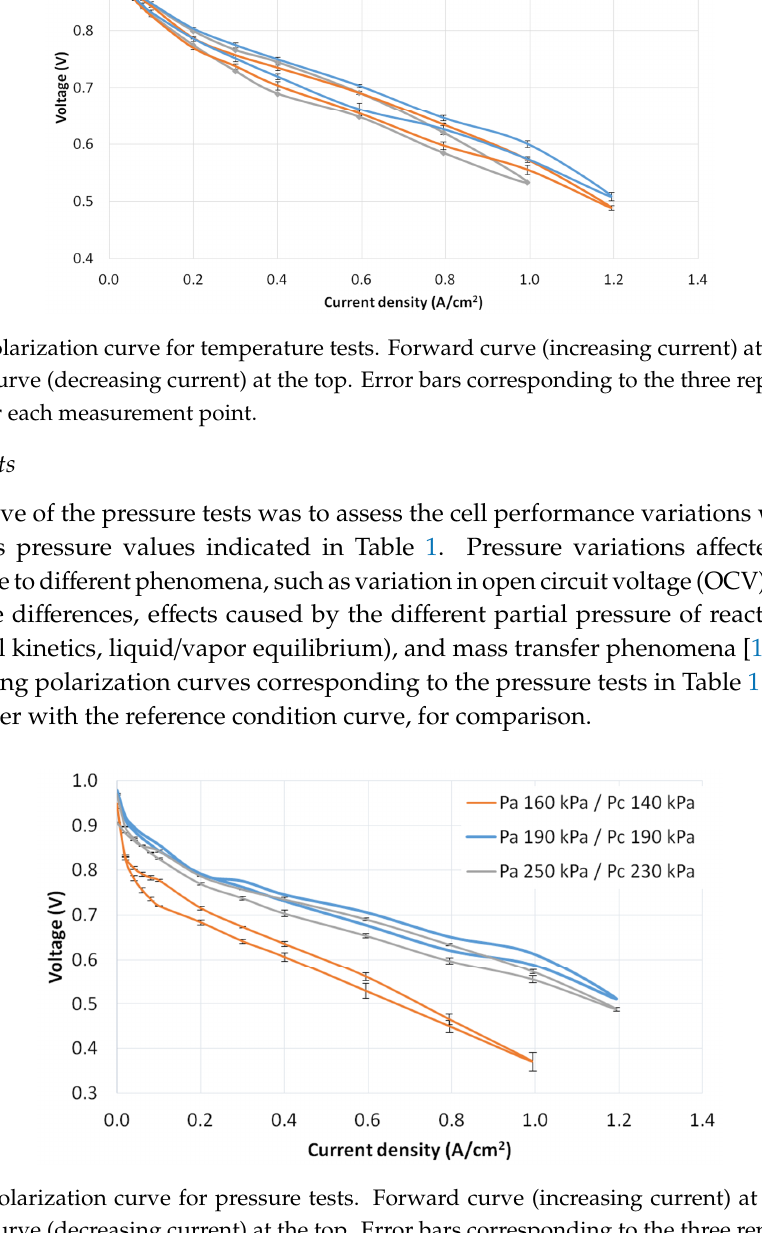
Figure 5. Polarization curve for pressure tests. Forward curve (increasing current) at the bottom; backward curve (decreasing current) at the top. Error bars corresponding to the three repetitions are included for each measurement point.